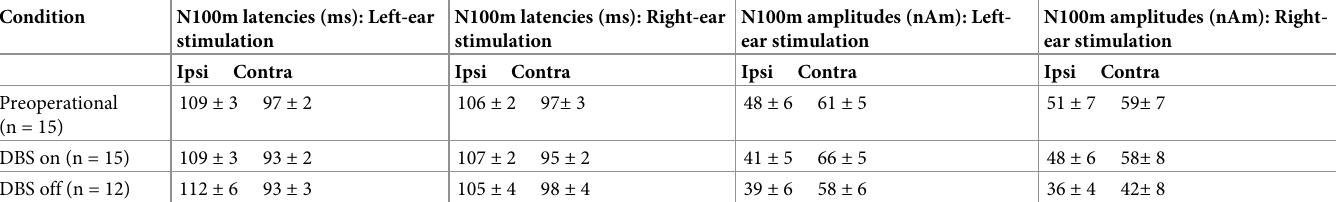
Table 2. N100m response latencies and